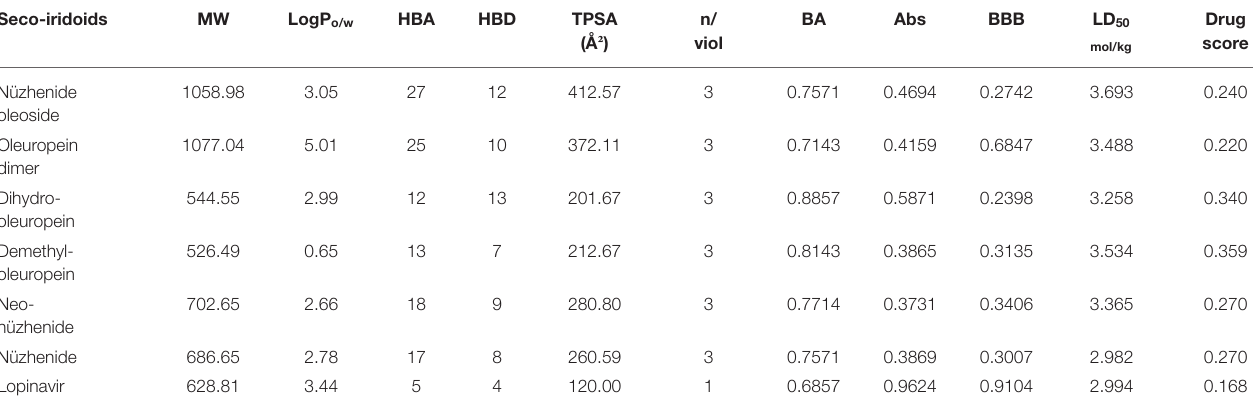
TABLE 2 | Results of virtual physicochemical, pharmacokinetics, and drug score screening.